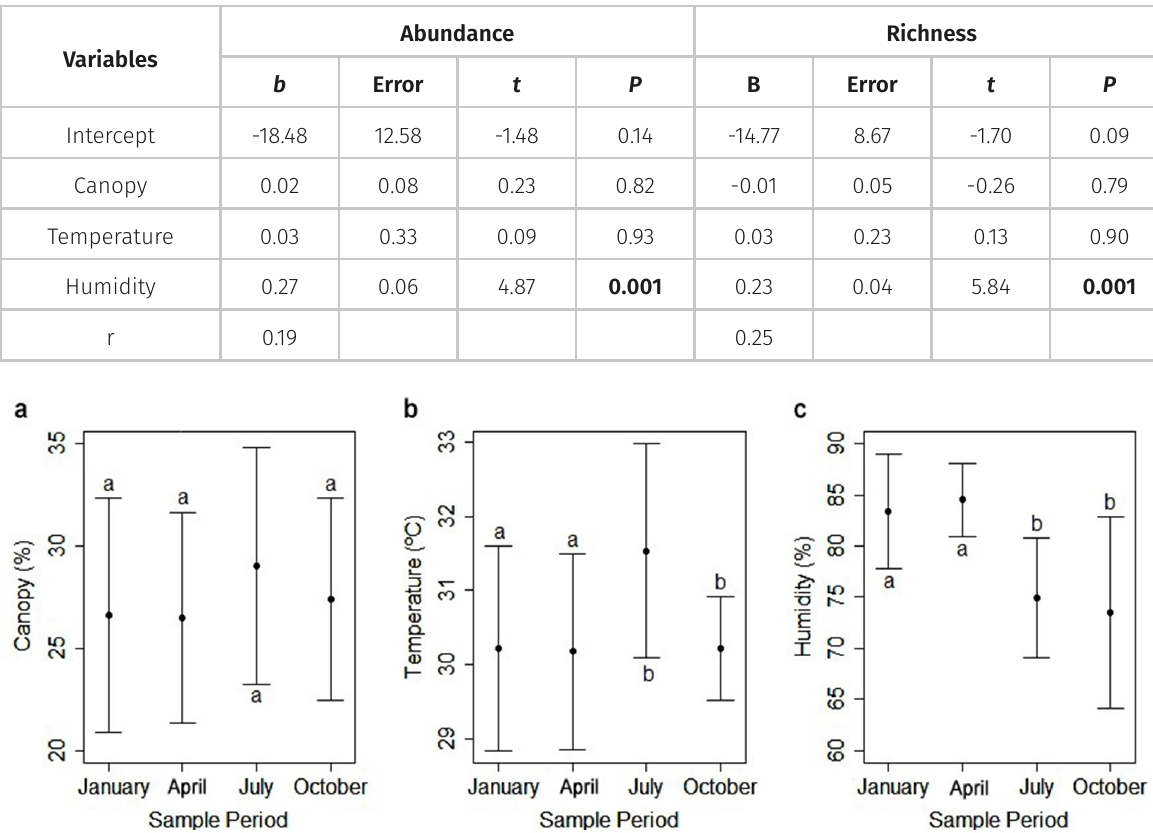
Table II. Influence of environmental variables on the abundance and richness of Hymenochaetales and Polyporales collected near the Silvio Braga HPP, in Santarém, PA. b = slope of the line, Error = Standard Error, t = critical t value, P = p value, r = r value. Values in bold, significant at ≤ 0.05.